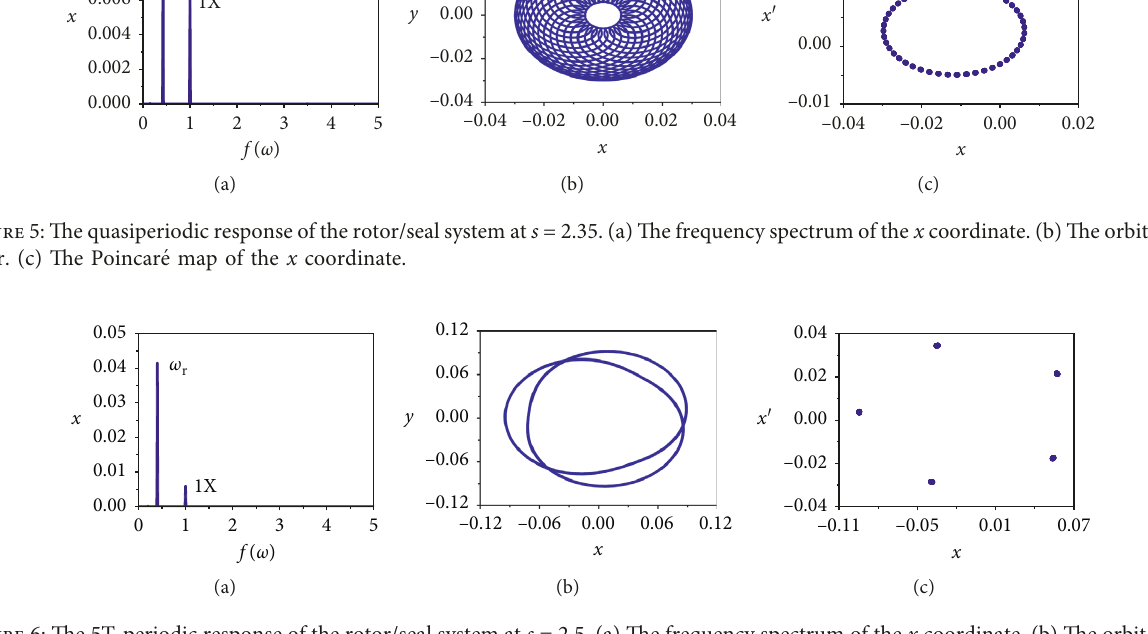
2.5. (a) The frequency spectrum of the x coordinate. (b) The orbit of the (cid:31)